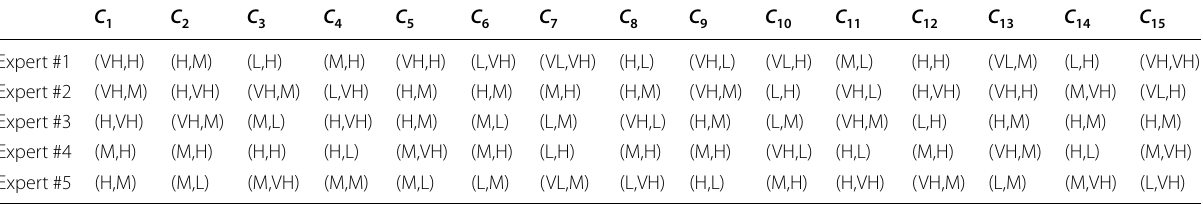
Table 1 Expert opinion about factors affecting ICT staff abandon based on Z-number C 1